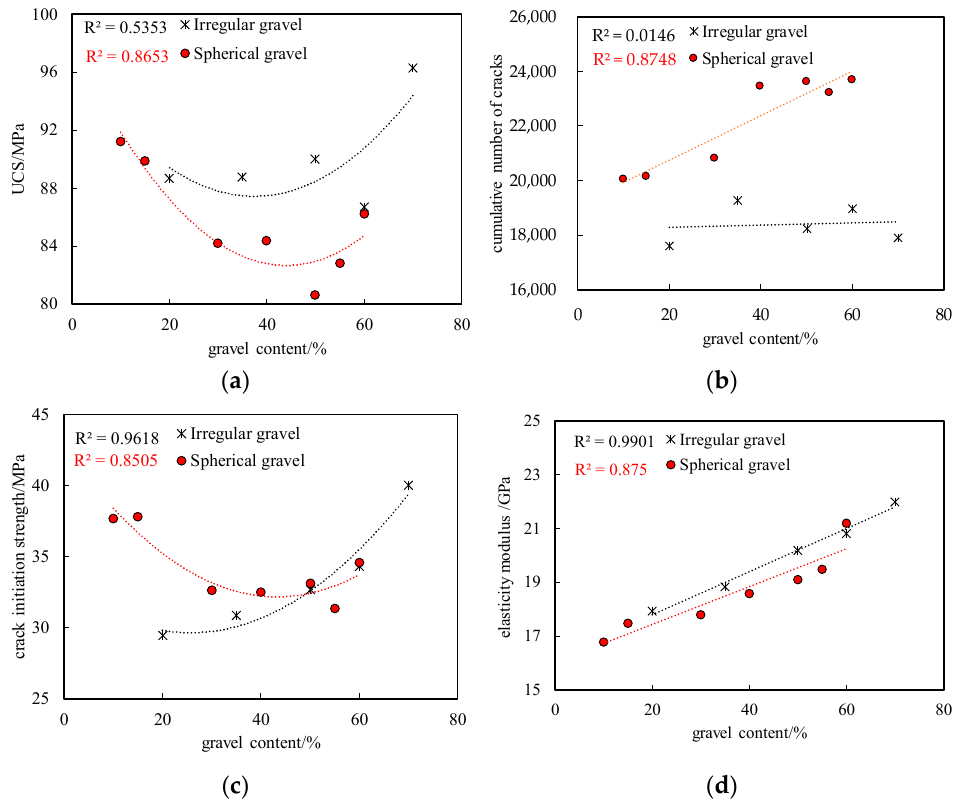
Figure 7. Effects of different gravel content on mechanical parameters and cumulative cracks. ( a ) Reaction between gravel content and ultimate; ( b ) Reaction between gravel content and cumulative; ( c ) Reaction between gravel content and crack initiation strength; ( d ) Reaction between gravel content and elasticity modulus.